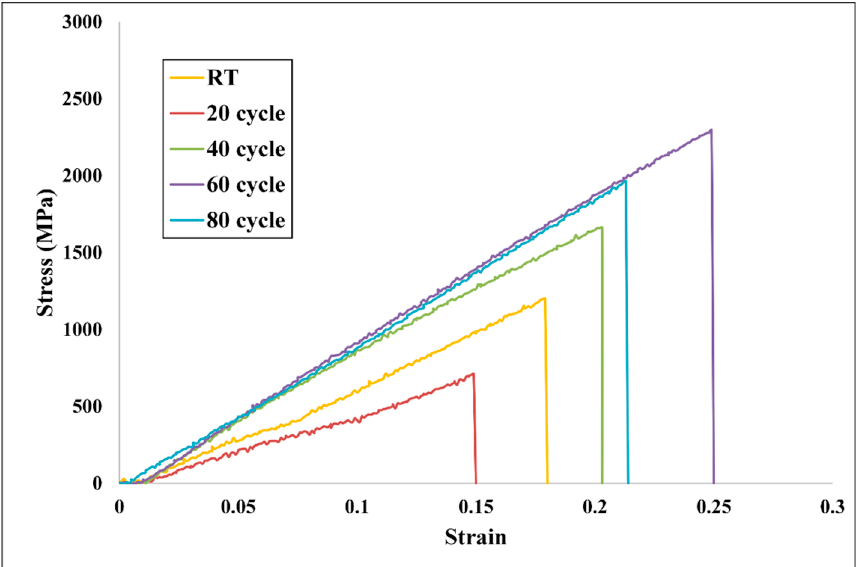
Figure 8. Stress–strain curves of fabricated CFRP composites before and after 20, 40, 60 and 80